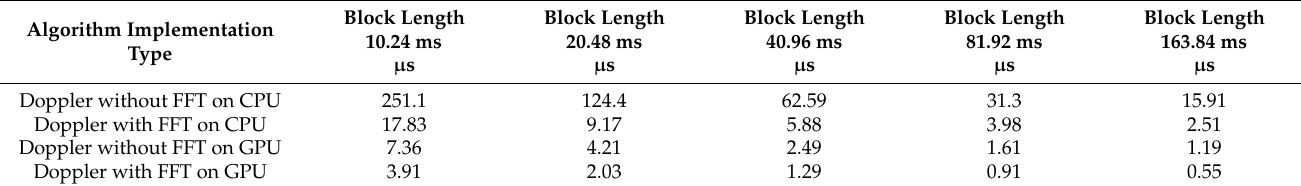
Table 1. Experimental running time of the algorithms per one input sample, with different block durations.